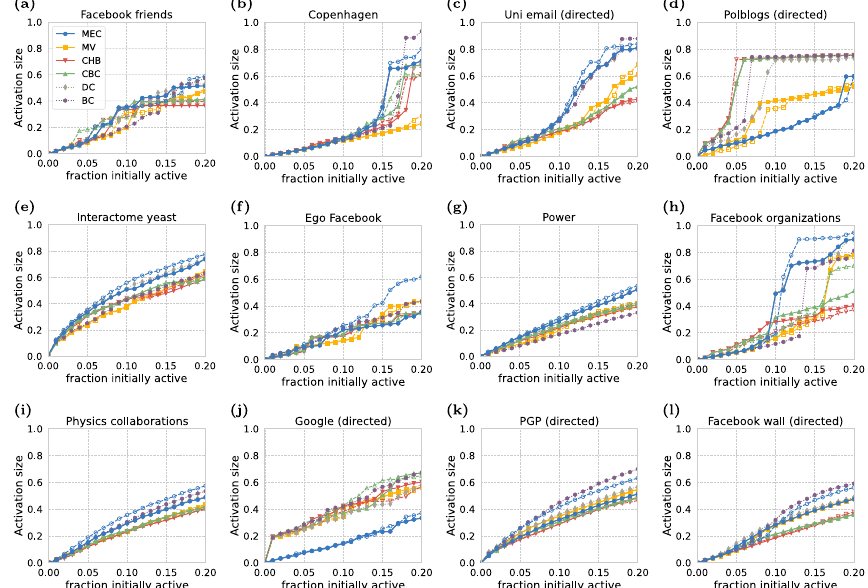
Fig. 10 Activation size for map equation centrality (MEC), modularity vitality (MV), community hub-bridge (CHB), community-based centrality (CBC), degree centrality (DC), and betweenness centrality (BC) in twelve empirical networks under the linear threshold model with threshold t ′′ = 0.6 . Community structures are identified with Infomap; solid lines use the unrecorded link teleportation flow model, dashed lines use recorded node